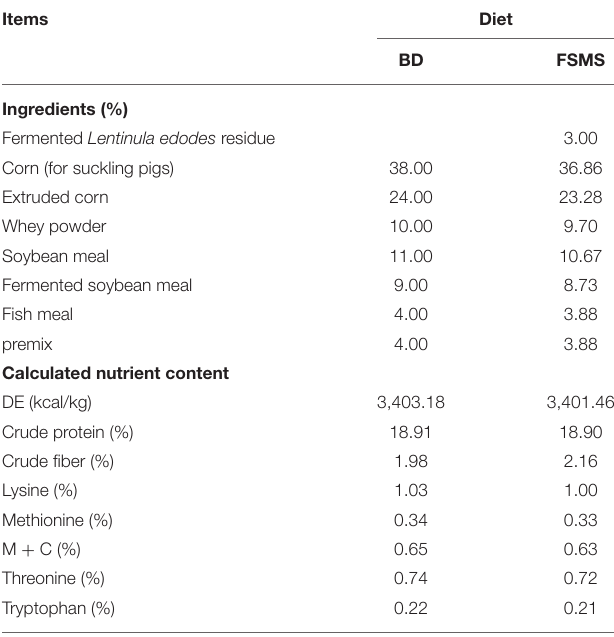
TABLE 1 | Composition and nutrient levels of the diets (%, as-fed